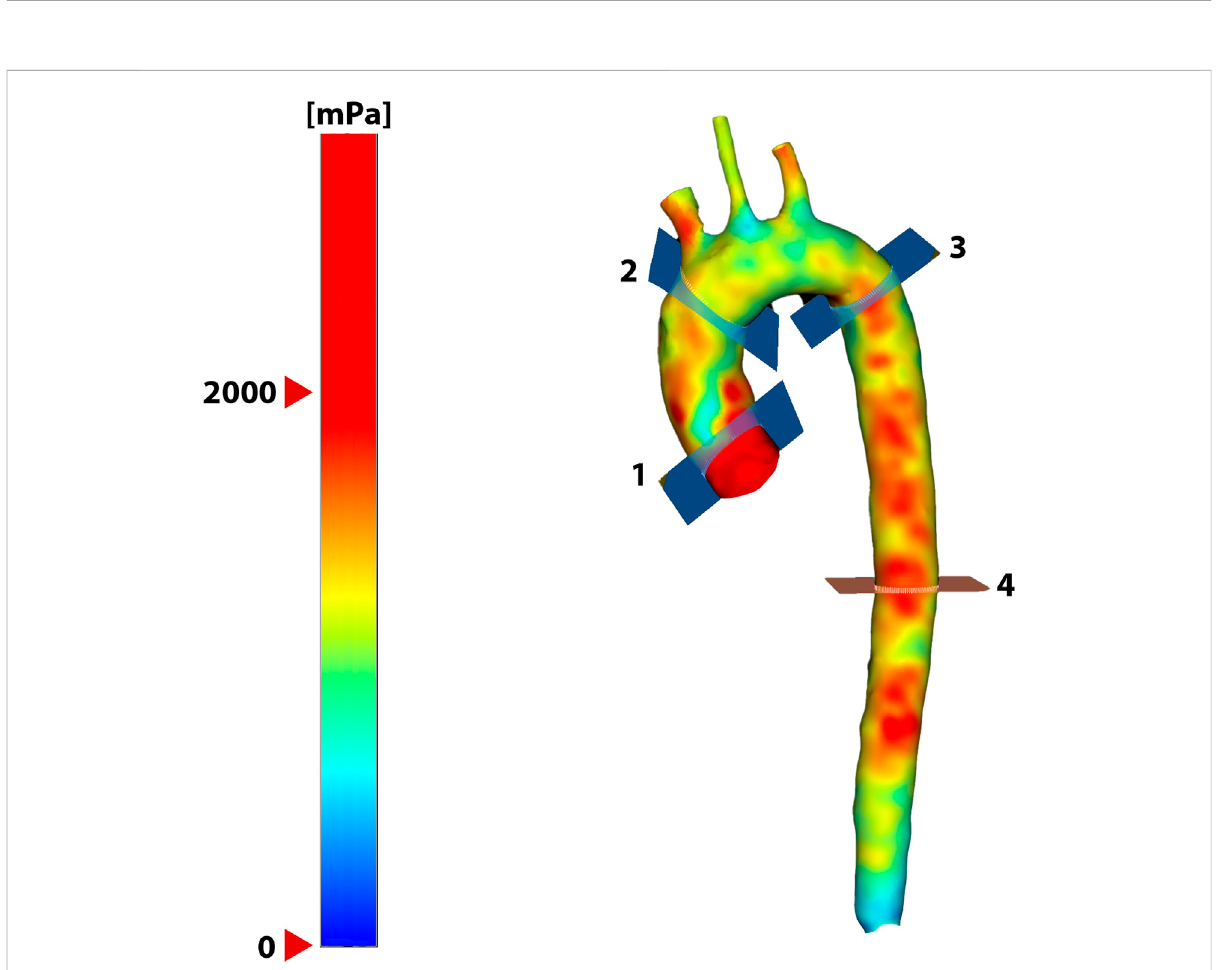
FIGURE 2 Image reconstruction of the aorta of a representative subject with a map of WSS at a given time of the cardiac cycle. The four reference planes used in the analyses are indicated with their respective